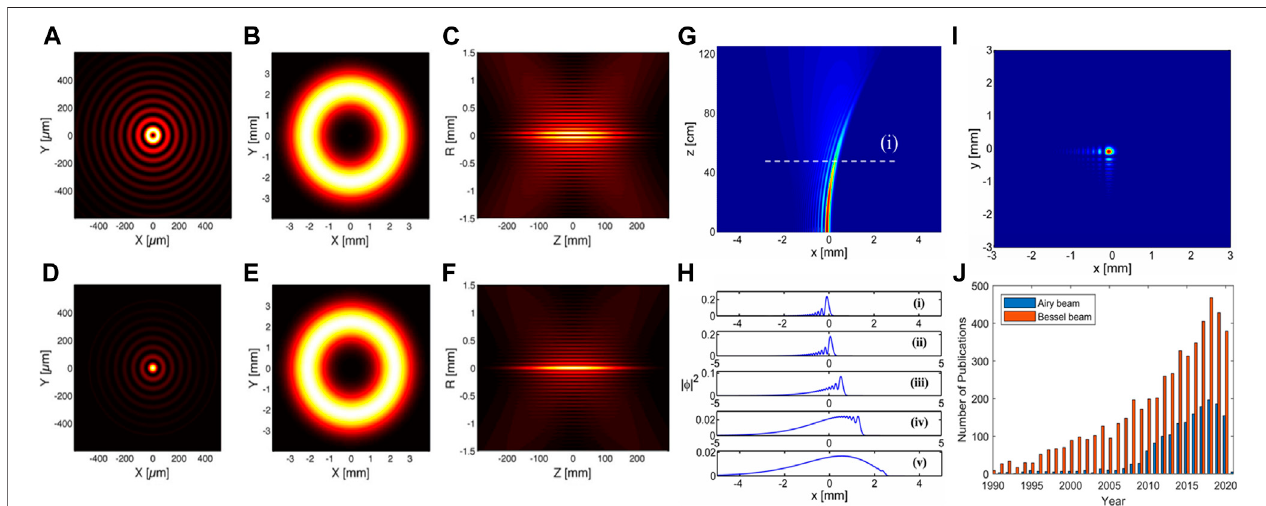
FIGURE2| Non-diffractingBesselandAirybeams.SquaremodulusoftheBessel – Gaussamplitudewithazimuthalorradialvectorpotential (A) atthefocus( z (cid:2) 0), (B) in the far- fi eld ( z (cid:2) 10 mm) and (C) near the focus; (D – F) similar to (A – C) but for vector potential amplitude along a Cartesian unit vector. (G) Dynamics of free-space propagation of an Airy beam with fi nite energy. (H) The normalized linear intensity pro fi les at 1) z (cid:2) 0 cm, 2) 31.4 cm, 3) 62.8 cm, 4) 94.3 cm, and 5) 125.7 cm, respectively. (I) 2D Airy beam with fi nite energy at a distant plane ( z (cid:2) 50 cm). (J) The number of publications for Bessel and Airy beams increases with the year. Reprinted with permission from OSA [7,